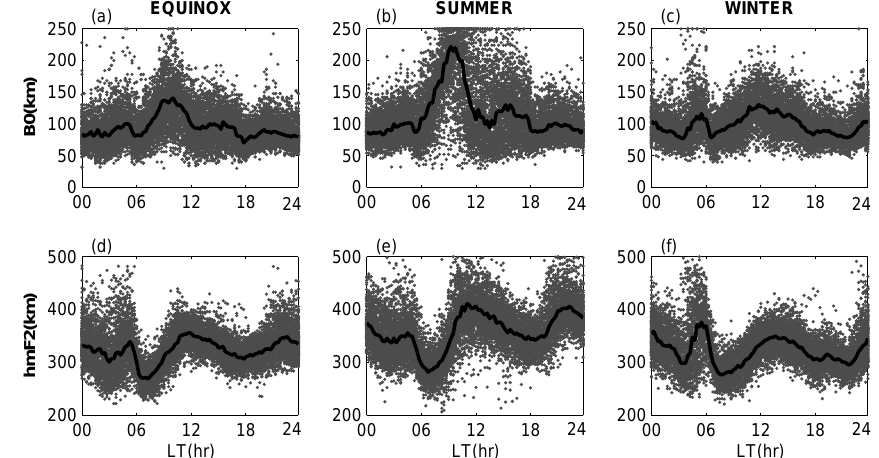
Fig. 1. Scatter plots (gray dots) and median values (solid line) show diurnal variation of B0 and hm F2 for (a) , (d) equinox, (b) , (e) summer, and (c) , (f) winter,